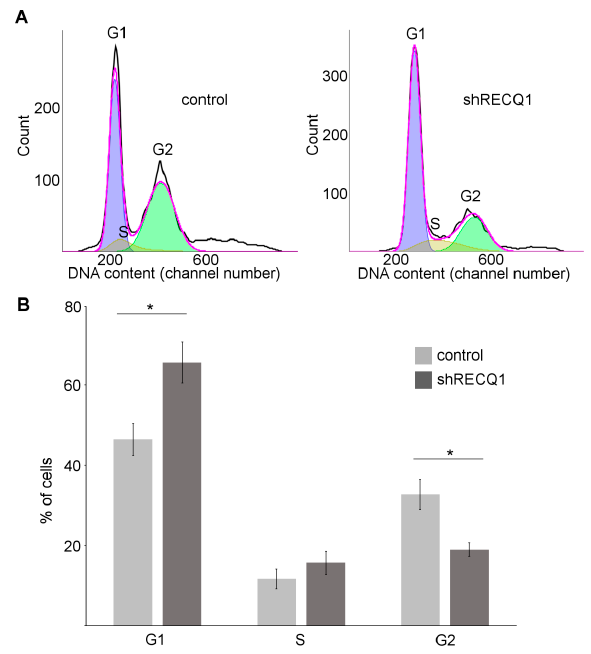
percentage of cells in the G2 phase (19 ± 2%), as compared to control cells (46 ± 4% cells in G1 phase and 33 ± 4% cells in G2 phase). No statistically significant differences in the percentage of cells in the S phase were observed between RECQ1-silenced and control cells (Figure 3).